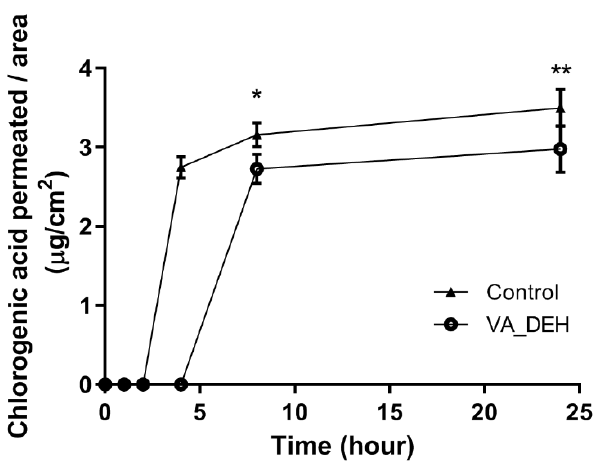
Figure 5. Hydrogel with 5% w / w dry extract (VA_DEH) permeation assay (mean ± SD). Control was used as the same components of the hydrogel without the polymer. Ordinary two-way ANOVA with Bonferroni’s multiple comparisons post test. * p < 0.05; ** p < 0.01. The amount of chlorogenic acid permeated from the VA_DEH was higher than 2 µg/mL after 8 h, reaching almost 3 µg/cm 2 after 24 h, which was similar to the control sample already permeated after 4 h of release (Table 7). The lower flow of chlorogenic acid